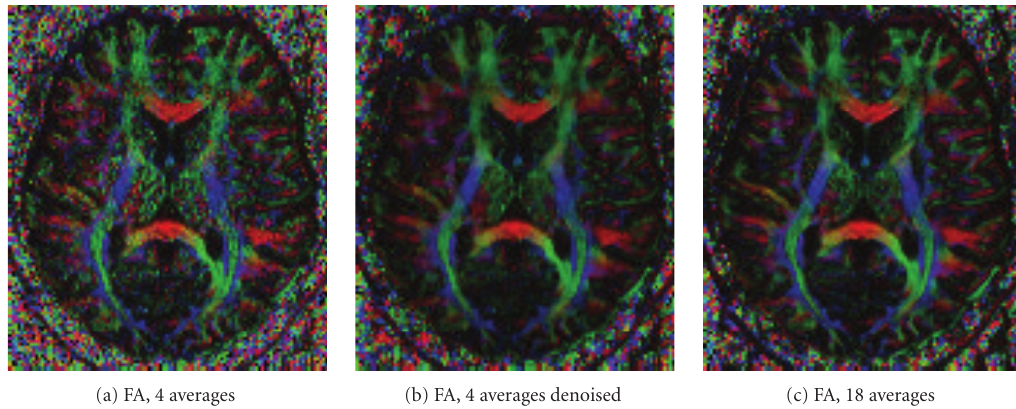
Figure 8: The noisy 4-average acquisition (a) is compared with the denoised acquisition (b) and a reference solution at 18 averages.